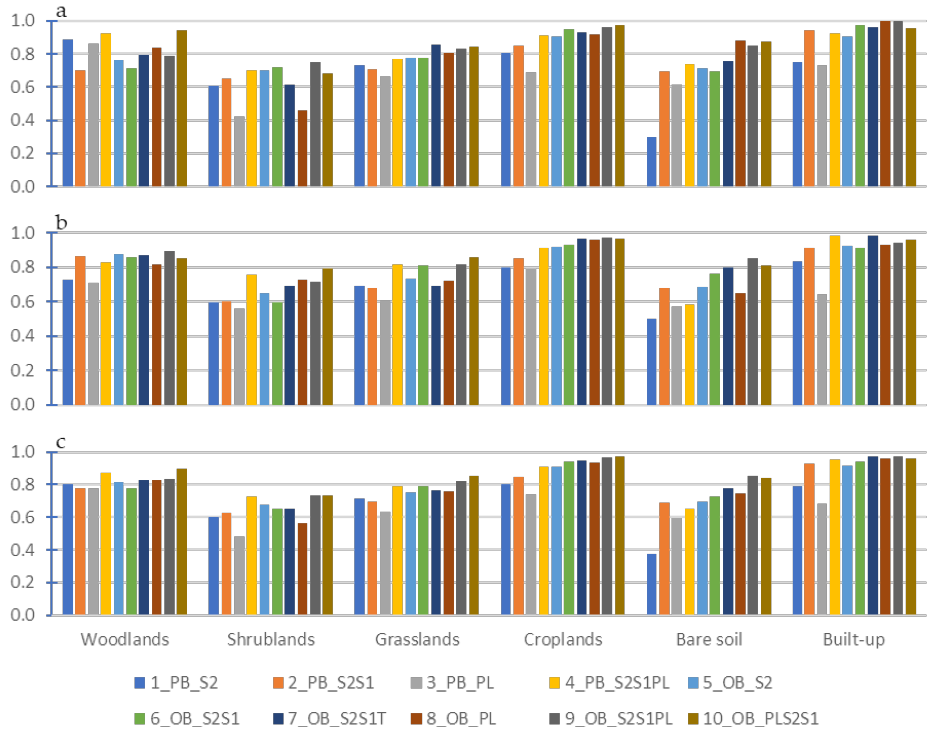
Figure 4. Comparison of user’s ( a ) and producer’s ( b ) accuracies, and F-scores ( c ) of the classification approaches (Y axis) obtained for the various LULC classes (X axis). Water bodies are omitted. Codes used in the legend for classification approaches are reported in Table 2.